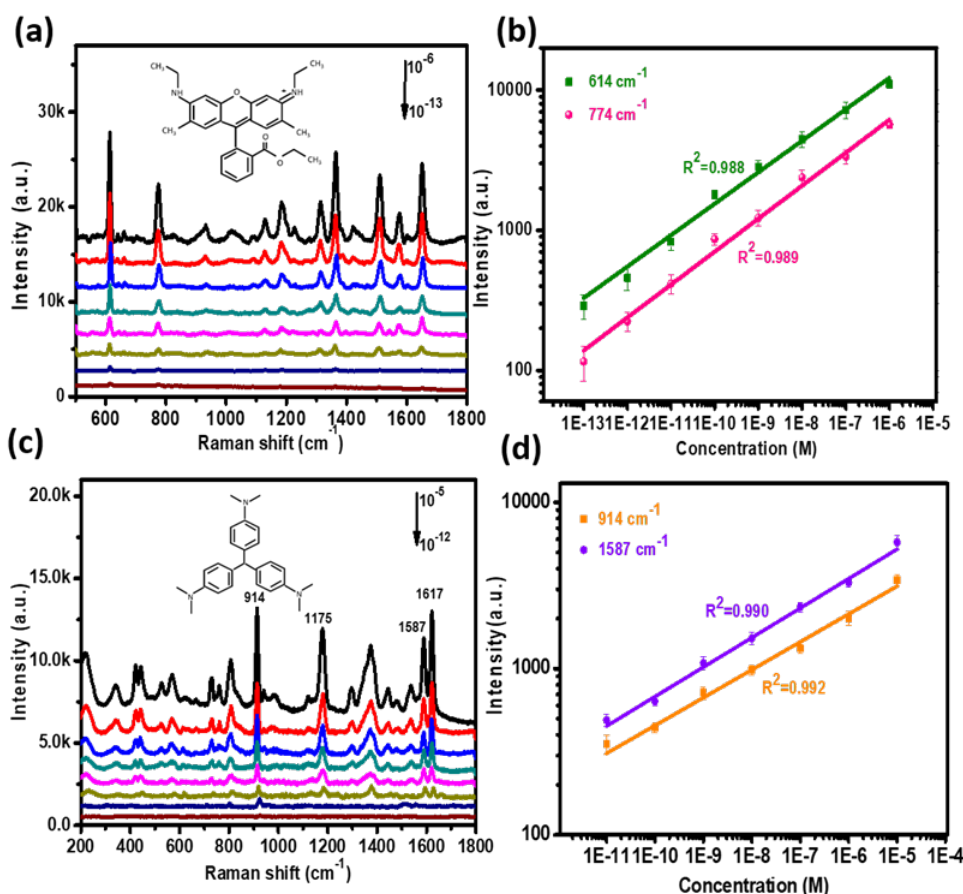
Figure 4. ( a ) Raman spectra of R6G from 10 − 6 to 10 − 13 M on the P–AgNPs@PMMA substrate. Insert: the structural formula of R6G molecule; ( b ) the Raman spectra of R6G at 614 and 774 cm − 1 as a function of the molecular concentration on the P–AgNPs@PMMA substrate in log scale; ( c ) Raman spectra of CV with concentration from 10 − 5 to 10 − 12 M on the P–AgNPs@PMMA substrate. Insert: the structural formula of CV molecule; ( d ) the Raman spectra of CV at 914 cm − 1 and 1567 cm − 1 as a function of the molecular concentration on the P–AgNPs@PMMA substrate in log scale.